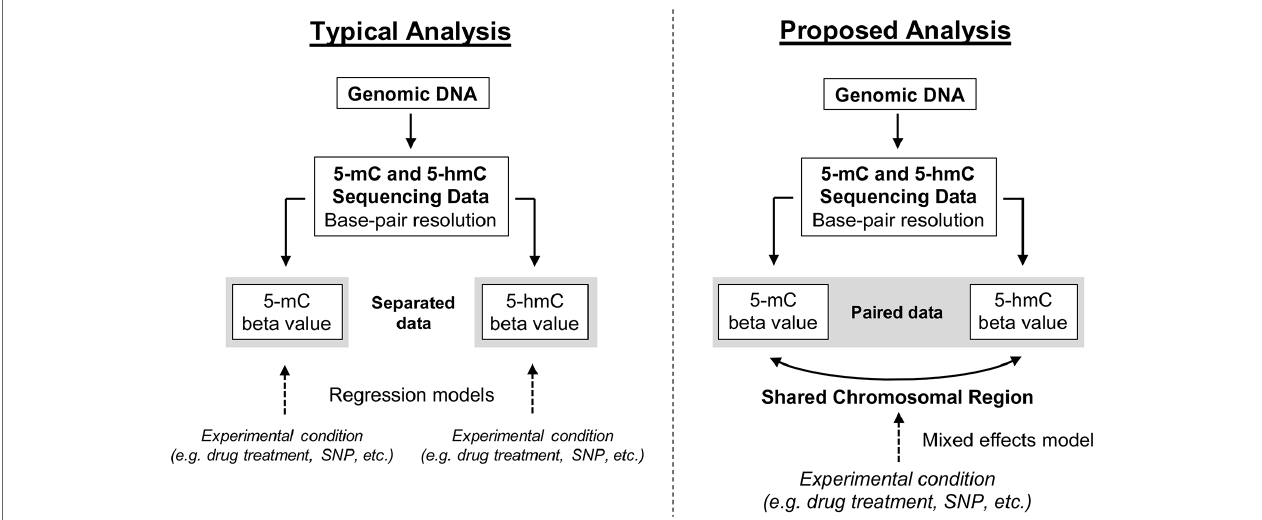
FIGURE 4 | Conceptual framework for reconciling 5-mC and 5-hmC data using a mixed effects modeling approach. Upon generating base-pair resolution 5-mC and 5-hmC data, the current analysis approach is to run separate regression models on the beta values for 5-mC and 5-hmC. However, this approach fails to account